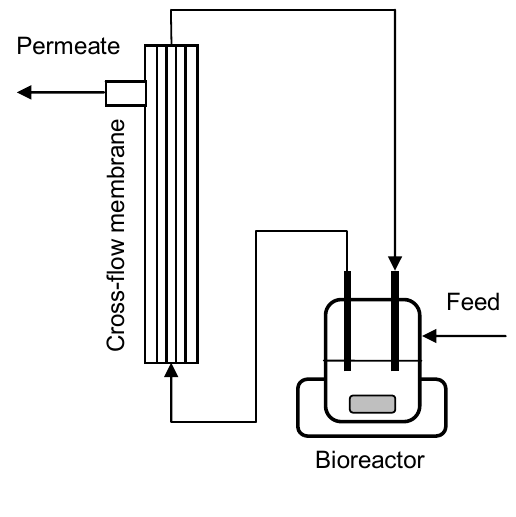
Figure 4. Schematic design of the MBR. The cross-flow membrane is externally coupled to the bioreactor, which is mixed with a magnetic impeller and heated with a water containing metal